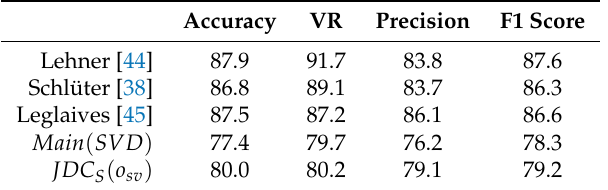
Figure 5. Result of singing voice detection on Jamendo. Table 2. Comparison of results of existing algorithms, Main ( SVD ) , and JDC S ( o sv ) (average accuracy of 5 runs). Note that Jamendo is not included in the training set of Main ( SVD ) and JDC S ( o sv ) .